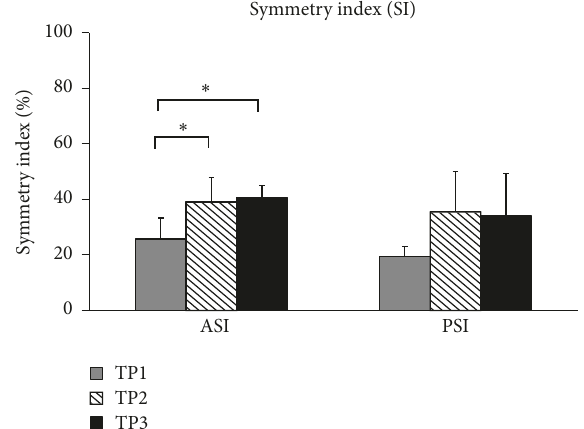
Figure5:Symmetryindexescalculatedforthefrontal(anterior)and dorsal (posterior) parts of the body. Significant difference ( 𝑝 < 0.05 ) is shown with asterisks.